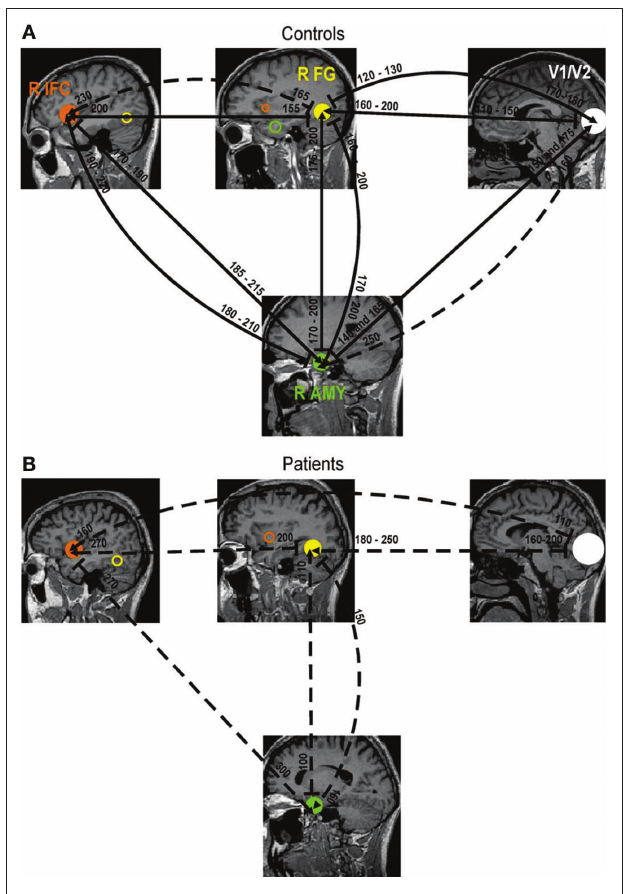
Figure  | Functional connections between brain regions active during an emotional processing task estimated through Meg. Robust influence amongst time courses (mutual information) can be derived between the right inferior frontal gyrus (IFG), FG, visual cortex (V1/V2) and amygdala (AMY) in healthy controls (A) . Coupling between these regions become more isolated in patients with schizophrenia, with reductions in the relatedness between two sources (dashed lines) as well as deviations in activation onset and latency (B) . Reproduced, with permission, from Ioannides et al. (2004).